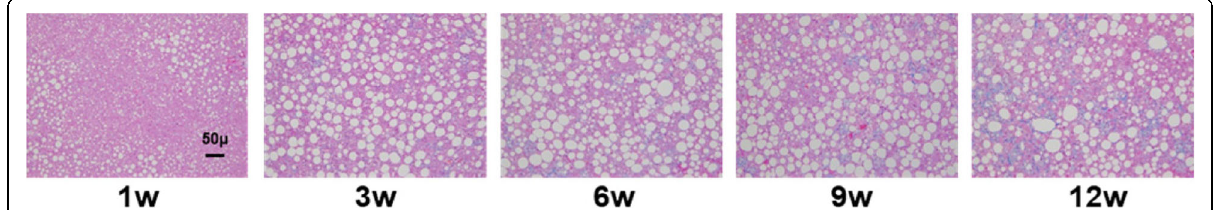
Fig. 4 Representative liver histopathology in mice fed a choline-deficient, L -amino acid defined, high-fat diet or a standard diet for 6 to 12 weeks. Images show Masson ’ s trichrome staining of the liver. Fibrosis was first observed at 6 weeks and became worsened by 12 weeks. Scale bar, 50 μ